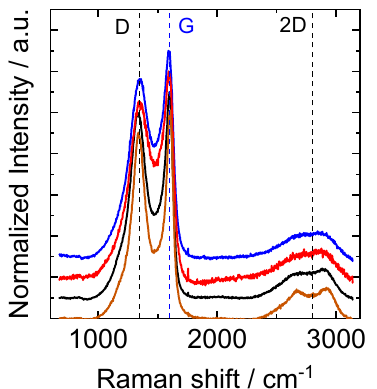
Figure 4. Raman spectra of the samples obtained from EOL (brown), PL (blue), KL (red) and KL loaded with Ketjen black (black). Spectra were normalized regarding the maximum intensity and shifted for clarity.